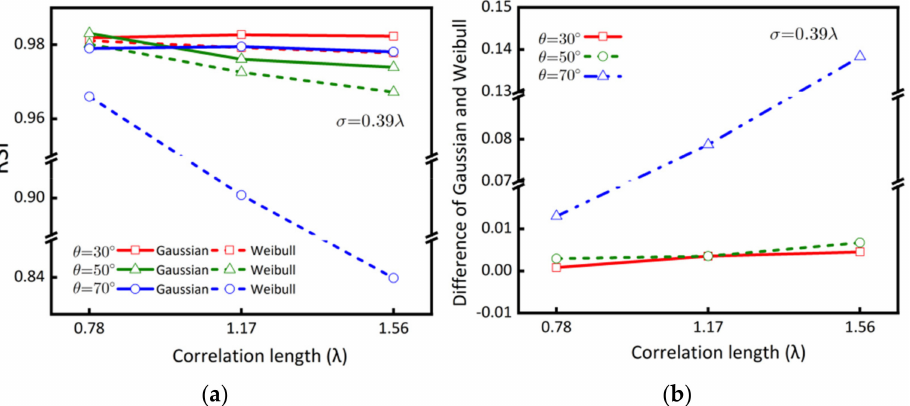
Figure 10. Comparison of RSI between Gaussian and Weibull HPDs surface as a function of correlation length, at three look angles of 30, 50, and 70 degrees; ( a ) RSI, ( b ) Difference of